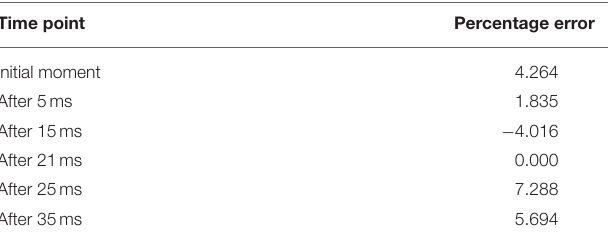
TABLE 2 | Comparison of experimental results with results obtained using numerical simulation; the percentage error of the area of the cross-section of the RBC obtained in numerical simulation, compared to the value of area calculated from experimental data, for the second initial position of the